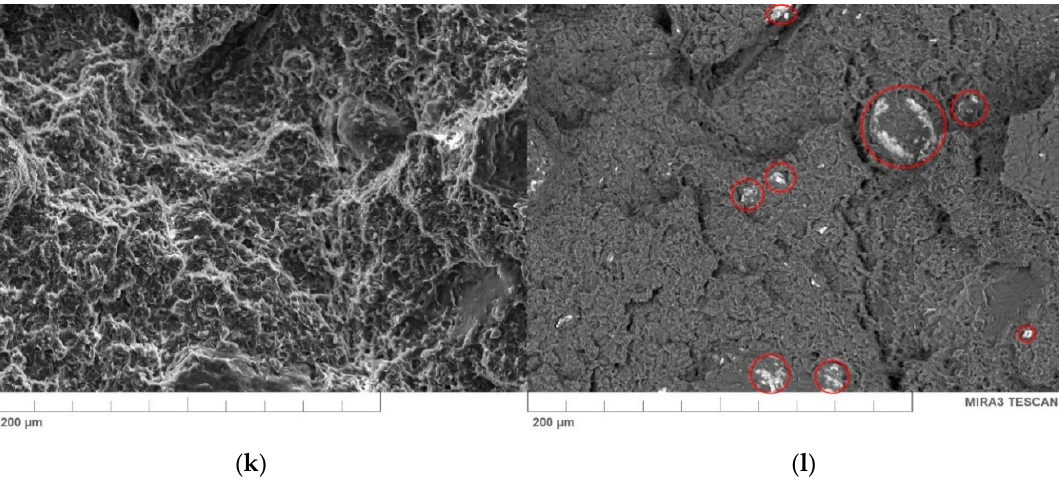
Figure 12. Scanning electron microscopy (SEM) images of fractured surface: ( a , b ) pure PE-wax, ( c , d ) wax / 0.1BNT, ( e , f ) wax / 0.4BNT, ( g , h )wax / 0.8BNT, ( i , j ) wax / 1BNT, ( k , l ) wax / 5BNT (magnification 1000 × ), SE (left) and BSE (right).